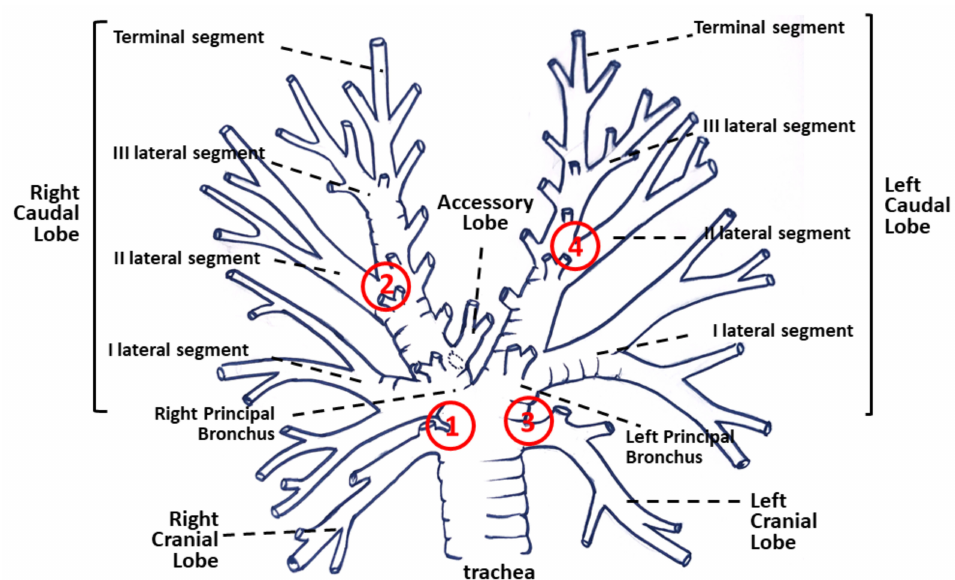
Figure 1. Position of bronchial biopsies: (1) Between right cranial bronchus and principal bronchus; (2) between second (II) right lateral segment and principal bronchus; (3) between left cranial bronchus and principal bronchus; and 4) between second (II) left lateral segment and principal bronchus.